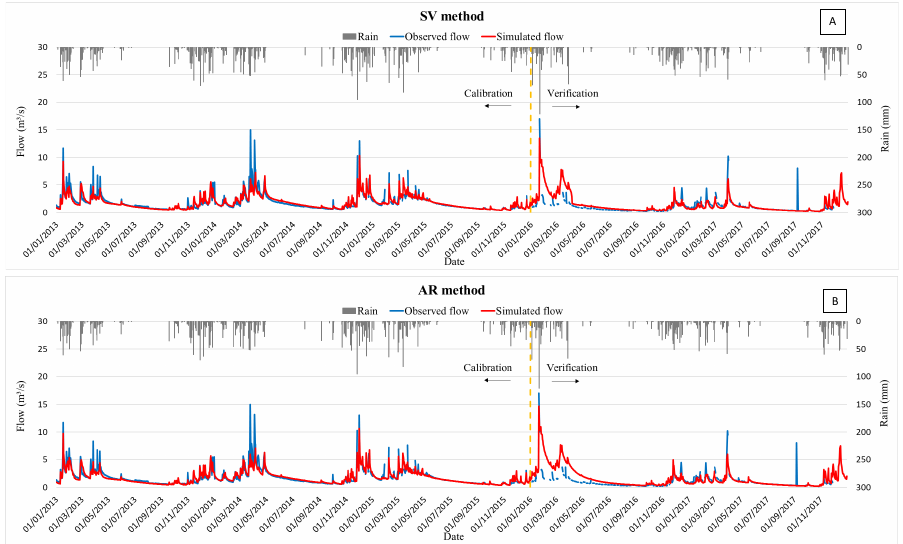
Figure 4. Observed and simulated hydrographs in the calibration period (2013 to 2015) and the verification period (2016 to 2017): ( A ) SV method; ( B ) AR